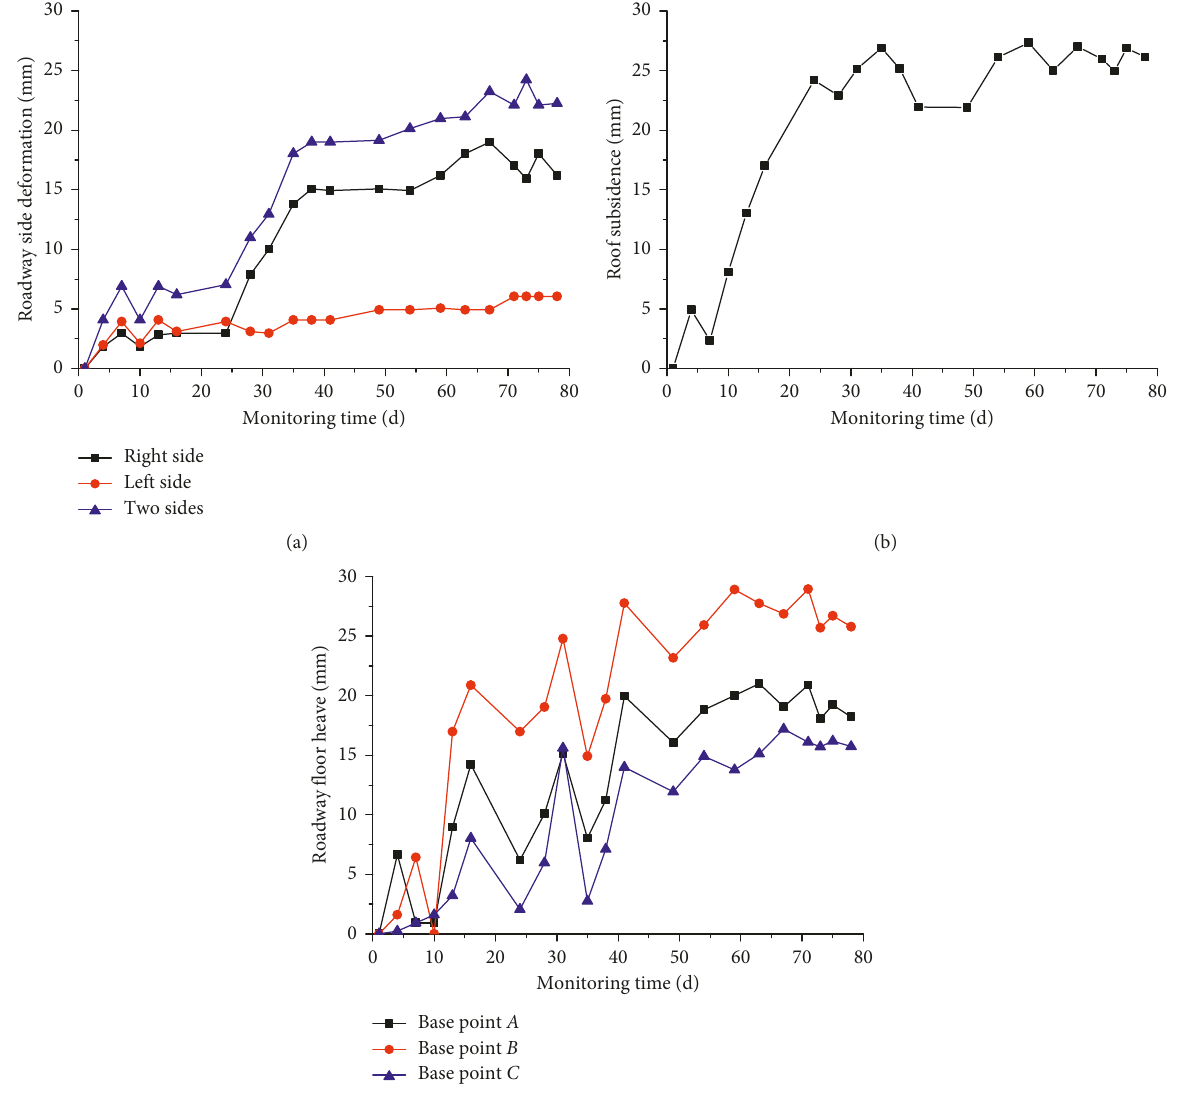
Figure 19: Displacement distribution curves of roadway-surrounding rock. (a) Roadway sides. (b) Roof. (c) Floor.